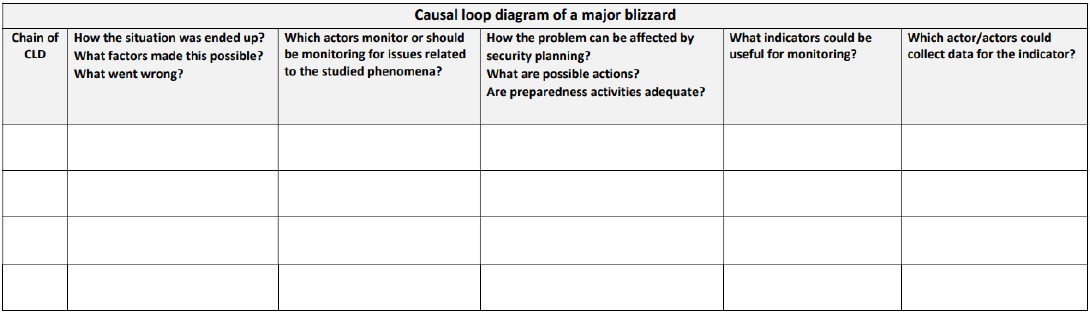
Figure 4. Template for collecting discussion notes in the workshop.